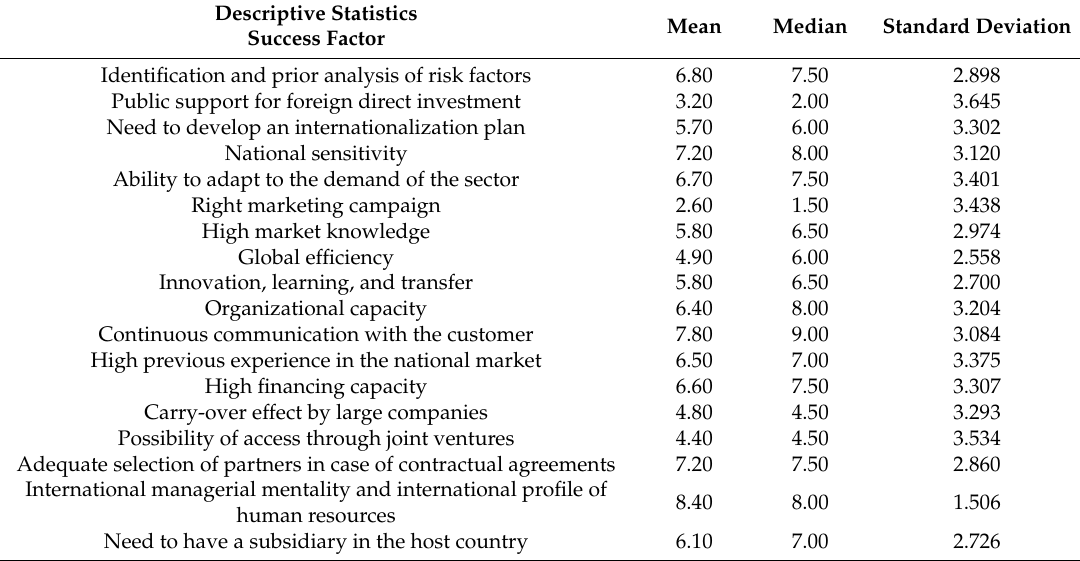
Table 11. Descriptive statistics of the answers about the success